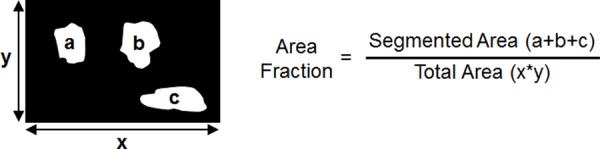
MSER terminology explanation.Methodology for calculating area fraction of a MSER segmented image. Area fraction was the metric used to quantify the performance of the MSER algorithm.